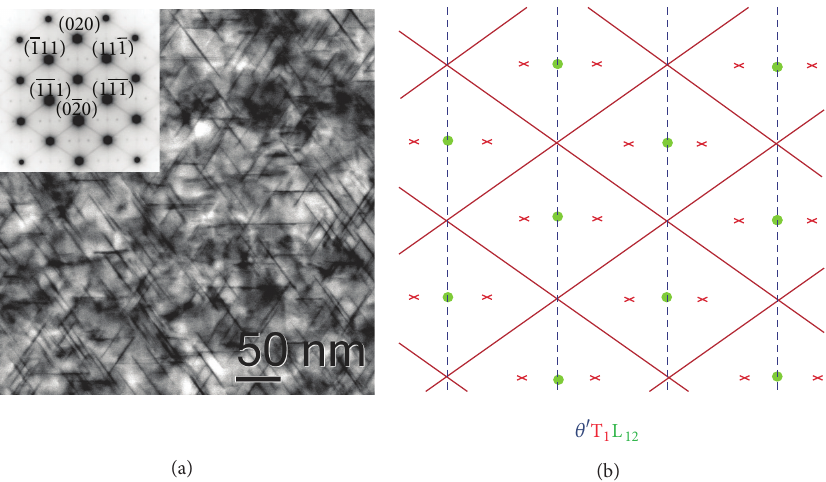
Figure 1: Evolution of the microstructure as observed by TEM. (a) Typical bright field image showing a complex microstructure with the T 1 , 𝜃 󸀠 , and 𝛽 󸀠 precipitates and the corresponding [101] selected area diffraction pattern (SADP). (b) Schematic of a simulated diffraction pattern that assigns the reflections and streaks in the SADP to the corresponding precipitates.